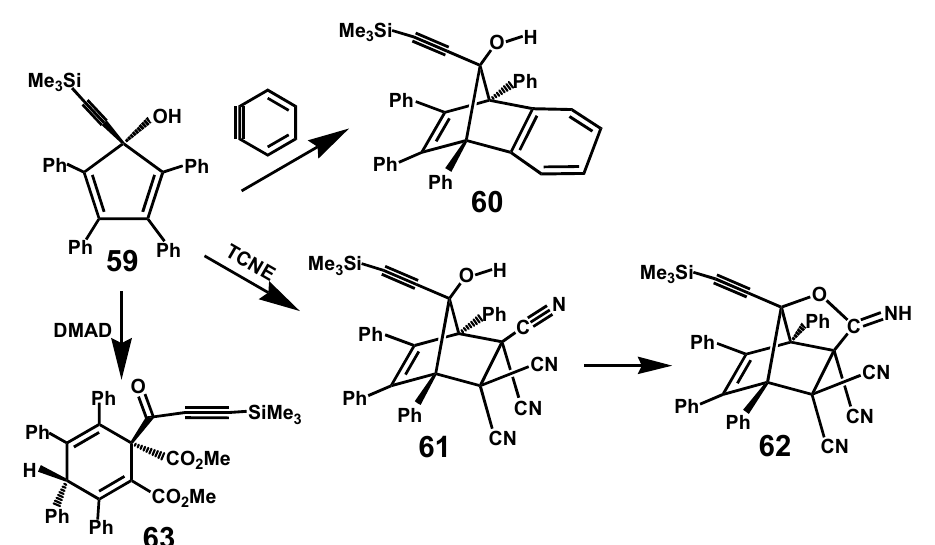
Scheme 22. Diels-Alder reactions of 5-trimethylsilylethynyl-1,2,3,4-tetraphenylcyclopentadien-5-ol with benzyne, TCNE and DMAD.